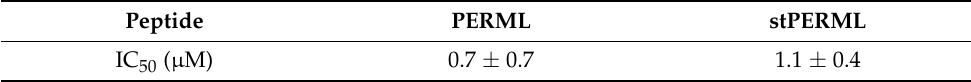
Table 1. ER α binding affinity (IC 50 ) of PERML and stPERML.